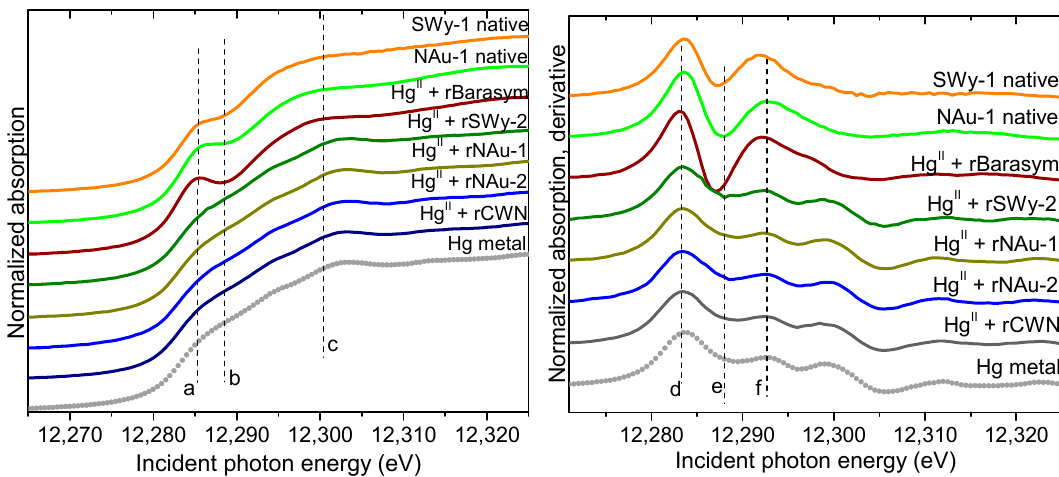
Figure 3. Hg L III -edge XANES spectra ( left ) and derivative ( right ) obtained from the solids in systems with clays of different Fe content reduced by the CBD method. Spectra are compared to that of Hg(II) in the native (un-reduced) clays and to the Hg(0) standard (symbols). The vertical dashed lines (a–f) are a guide to the eye, delineating features corresponding to the different valence states of Hg.